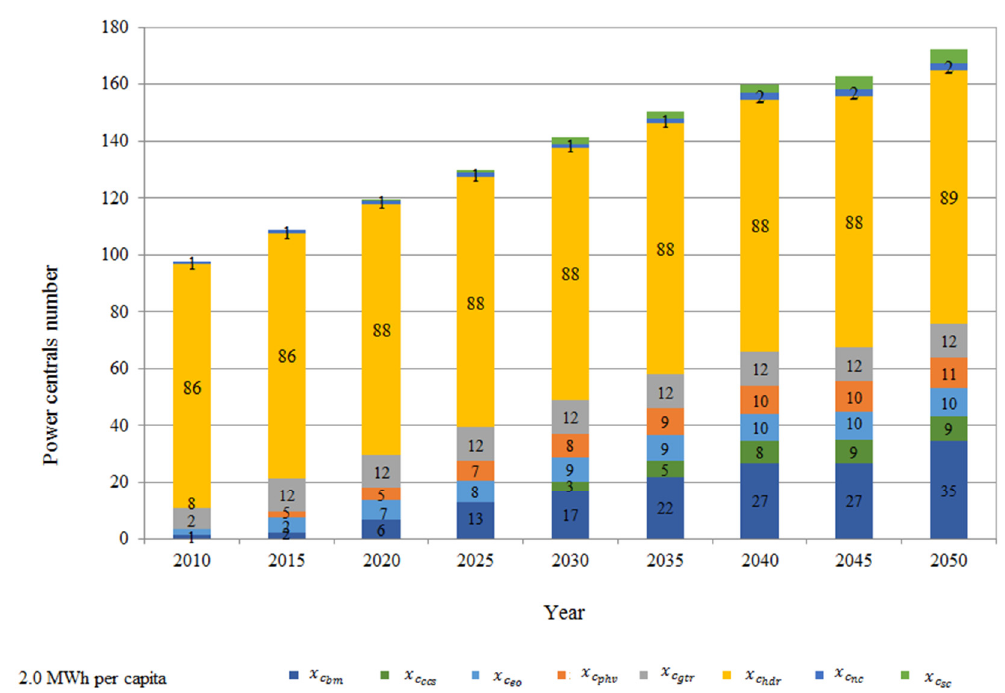
Figure 11. Optimized power plants number from clean energy resource for 2.0 MWh per capita demand with the LVF model.